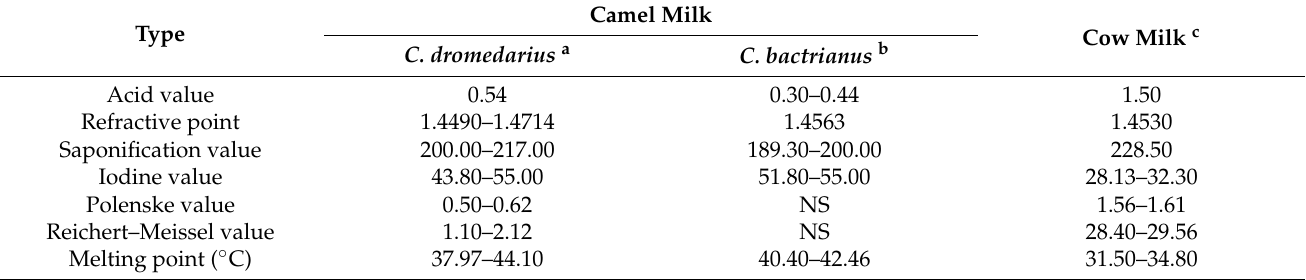
Table 3. Physicochemical properties of CM